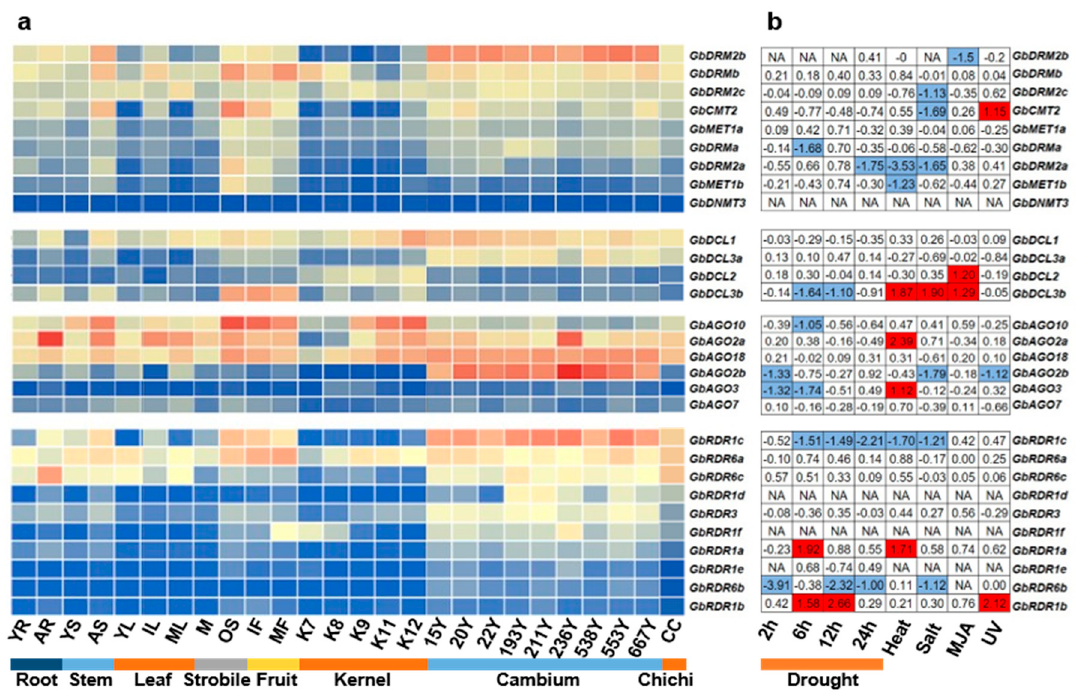
Figure 4. Expression profile of DNA methylation pathway genes. ( a ) Expressions in different tissues of G. biloba , including the root of young seedlings (YR) and adults (AR); stem of young seedlings (YS) and adults (AS); leaf of young seedlings (YL); immature leaf of adults (IL) and mature leaf (ML); microstrobilus (M) and ovulate strobilus (OS); immature fruit (IF, June) and mature fruit (MF, Oct.); kernels in July (K7), Aug. (K8), Sep. (K9), Nov. (K11) and Dec. (K12); cambium from 15-, 20-, 22-, 193-, 211-, 236-, 538-, 553-, and 667-year-old trees; and chichi (CC). ( b ) Expression changes under different abiotic stresses. The number shows the log2 ratio of the expression after treatment to the control. Red and blue indicate the genes upregulated (log2 value > 1) and downregulated (log2 value < − 1), respectively. NA means not detected in the sample.